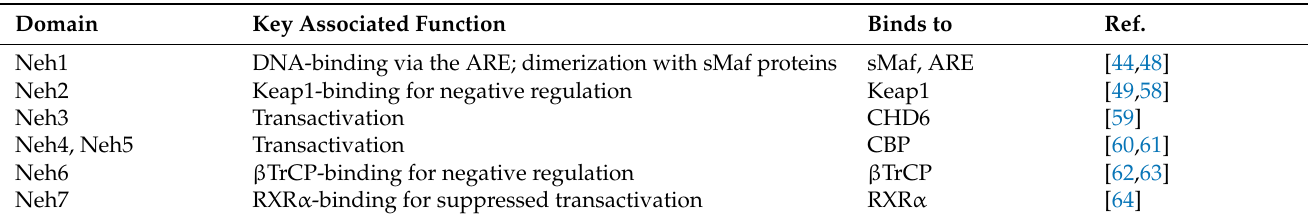
Figure 4. Domain structure of human Nrf2. Nrf2 contains seven conserved Neh domains. The Neh2 domain contains two motifs ( 29 DLG 31 and 79 ETGE 82 ) wherein Keap1 binds as a substrate adaptor for the Cul3-mediated ubiquitination and degradation of Nrf2. Table 2. Summary of functional domains of Nrf2 and their key binding